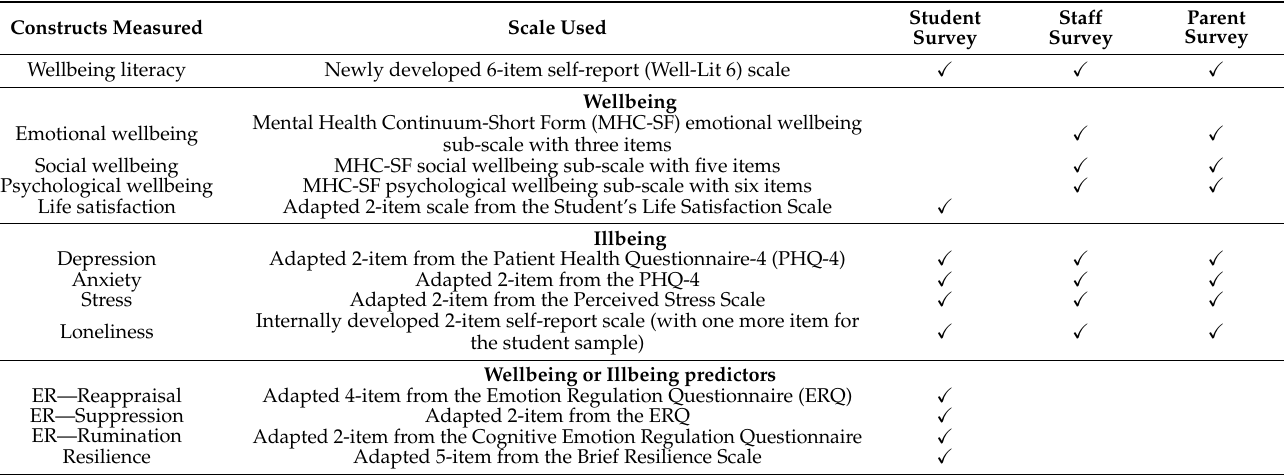
Table 2. Summary of survey